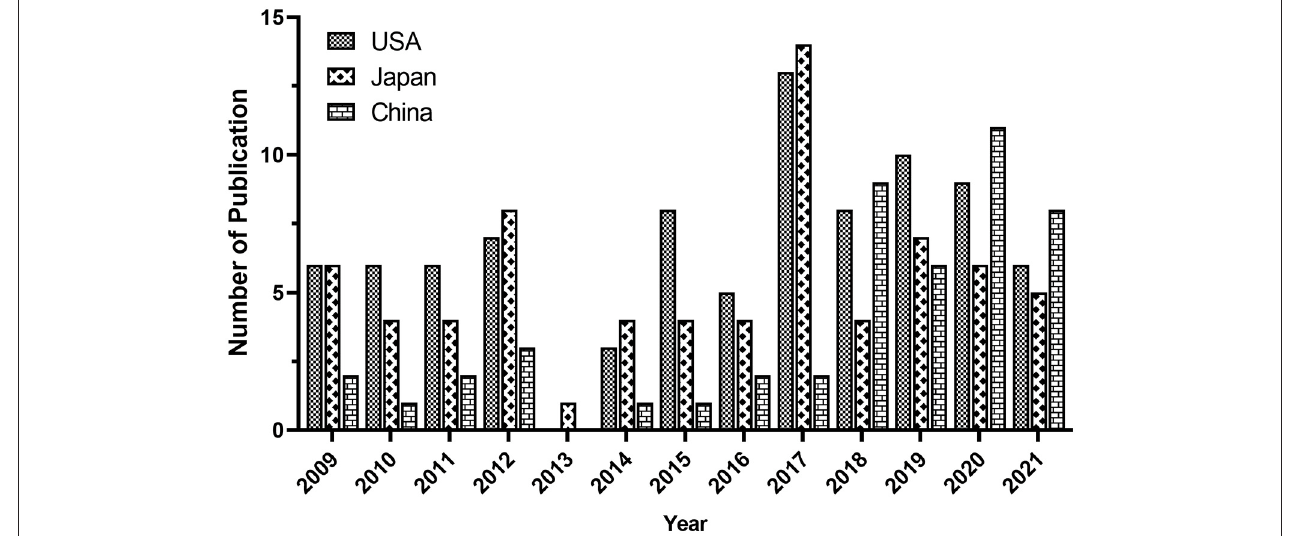
FIGURE 3 | The annual amount of publications on NMU researches from the top three countries from 2009 to 2021.